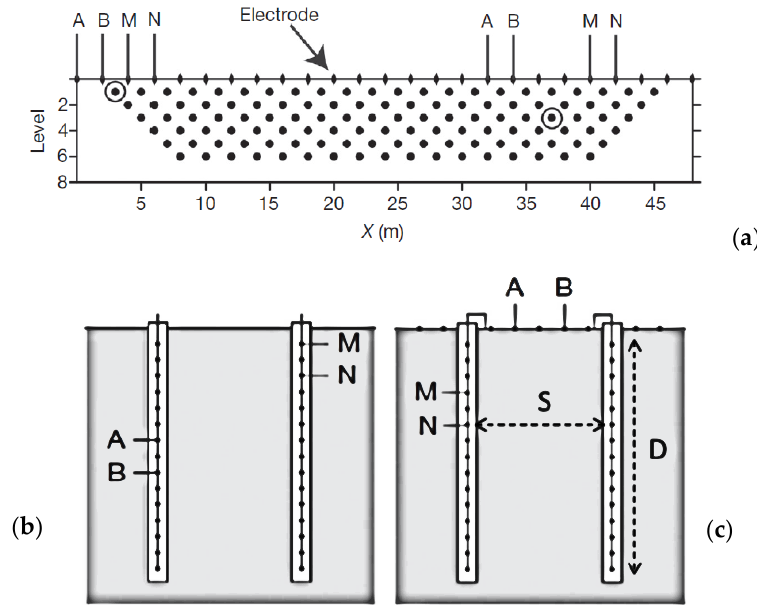
Figure 1. ( a ) Pseudo section setting for ERT acquisition with Dipole Dipole (DD) array, ( b ) cross borehole, and ( c ) cross borehole with surface. A , B , M , and N are electrodes. D is borehole depth; S is borehole separation. D/S > 1.5. Adapted from [14].